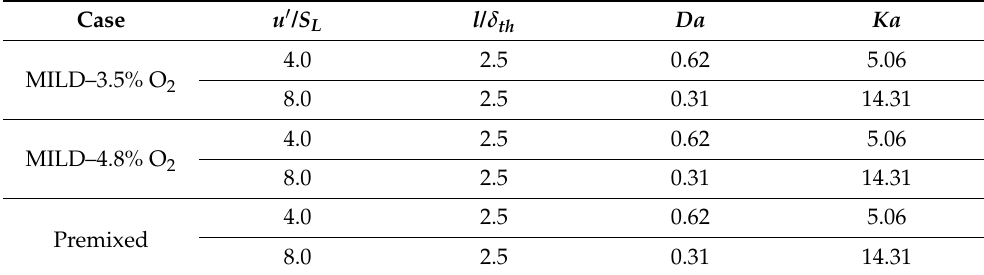
Table 2. Initial Turbulence